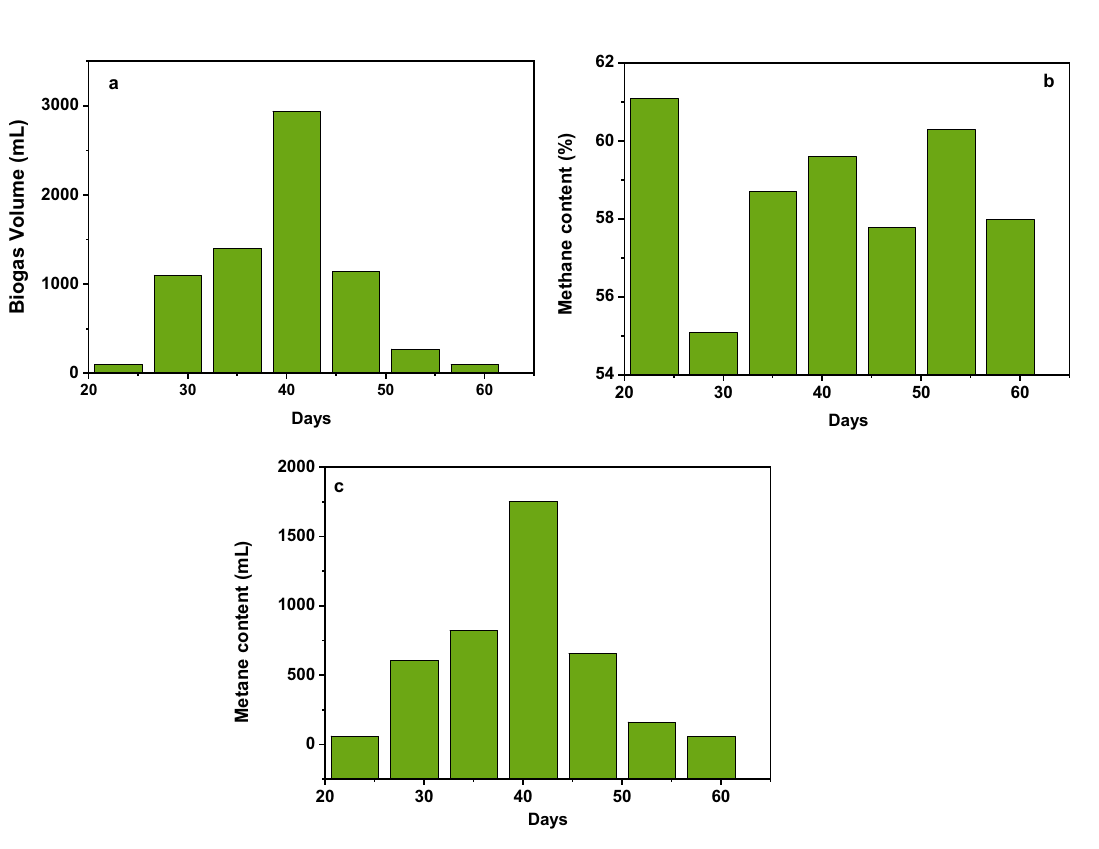
Figure 2. ( a ) Biogas production (mL) as a function of days, ( b ) methane content (%) as a function of days, ( c ) methane content (mL) as a function of days on a laboratory scale for preliminary